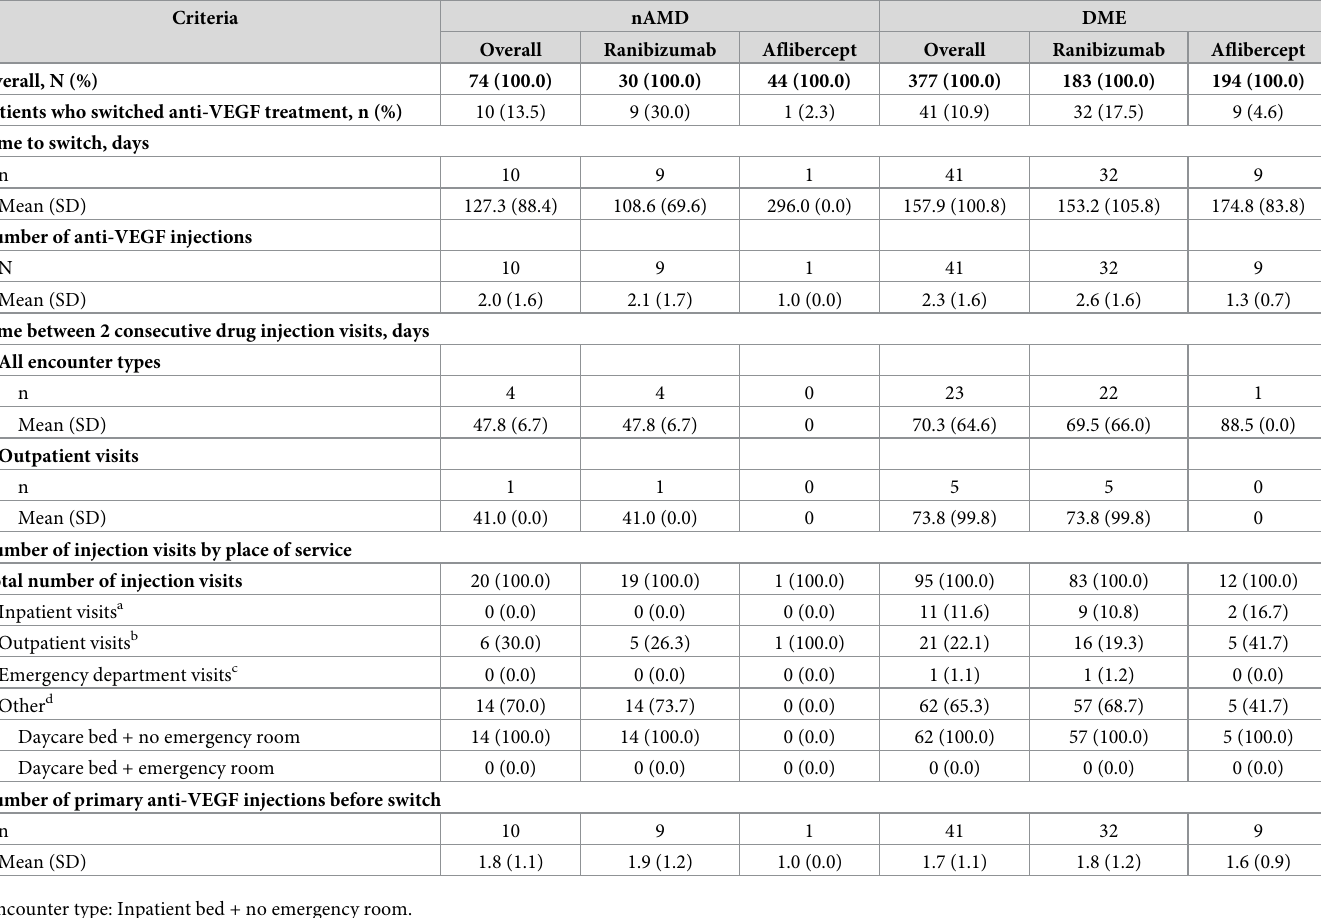
Table 4. Treatment patterns for patients who switched anti-VEGF treatment.